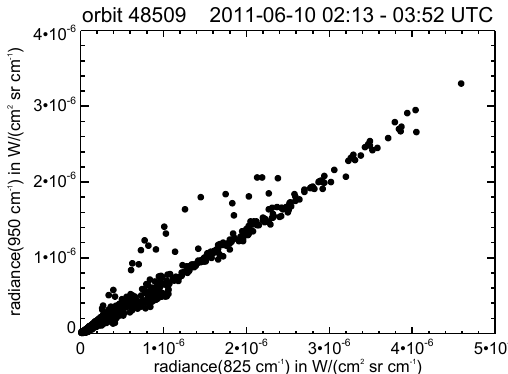
radiance in W/(cm 2 sr cm -1 ) Figure 5. Mean radiances below 30km tangent altitude for the Fig. 5. Mean radiances below 30km tangent altitude for the 825cm − 1 window versus the 950cm − 1 window for MIPAS orbit 825cm − 1 window versus the 950cm − 1 window for MIPAS orbit 48509. The measurements form a narrow band with some outliers 48509. The measurements form a narrow band with some outliers that are characteristic for volcanic ash. This orbit was measured six that are characteristic for volcanic ash. This orbit was measured six days after the Puyehue-Cordón Caulle eruption in Chile. days after the Puyehue-Cord´on Caulle eruption in Chile.